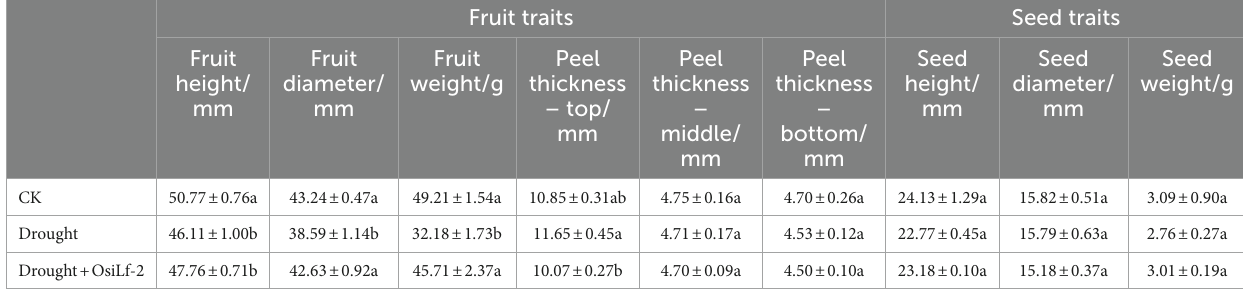
TABLE 1 Effects of different treatment groups on seed traits of Camellia oleifera.